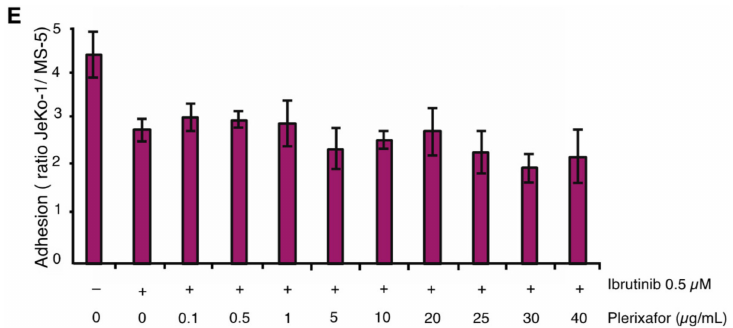
Figure 5. JeKo-1 and REC-1 cells express di ff erent cell surface levels of CXCR4 ( A ) Membrane expression level of CXCR4 in three di ff erent fractions of JeKo-1 and REC-1 cells without and with Plerixafor treatment (final concentration of 25 µ g / mL), presented as mean fluorescent intensity ( n = 3). ( B ) Chemotaxis of JeKo-1 (pink) and REC-1 (yellow) cells was measured by transwell migration assay towards CXCL12 without and with Plerixafor for 4 h (final concentration of 25 µ g / mL). Bars represent the number of migrating cells toward CXCL12 normalized to medium without CXCL12. ( C ) MCL cells were cocultured with either MS-5 or HS-5 stromal cells without and with 25 µ g / mL Plerixafor for 4 h and the number of adherent cells was quantified using flow cytometry ( n = 3 independent experiments and error bars represent SEM). Student’s t -test was performed, and the p value indicates di ff erences between the number of stromal cells adhered JeKo-1 cells in treated and untreated cells. ( D ) Plerixafor dose–response curve in JeKo-1 cells presented as mean fluorescent intensity ( n = 3). ( E ) JeKo-1 cells were treated with 0.5 µ M Ibrutinib for 1 h, then treated cells were cocultured with MS-5 cells in the absence or presence of di ff erent concentrations of Plerixafor for 4 h and the number of adherent cells were quantified using flow cytometry ( n = 3 independent experiments and error bars represent